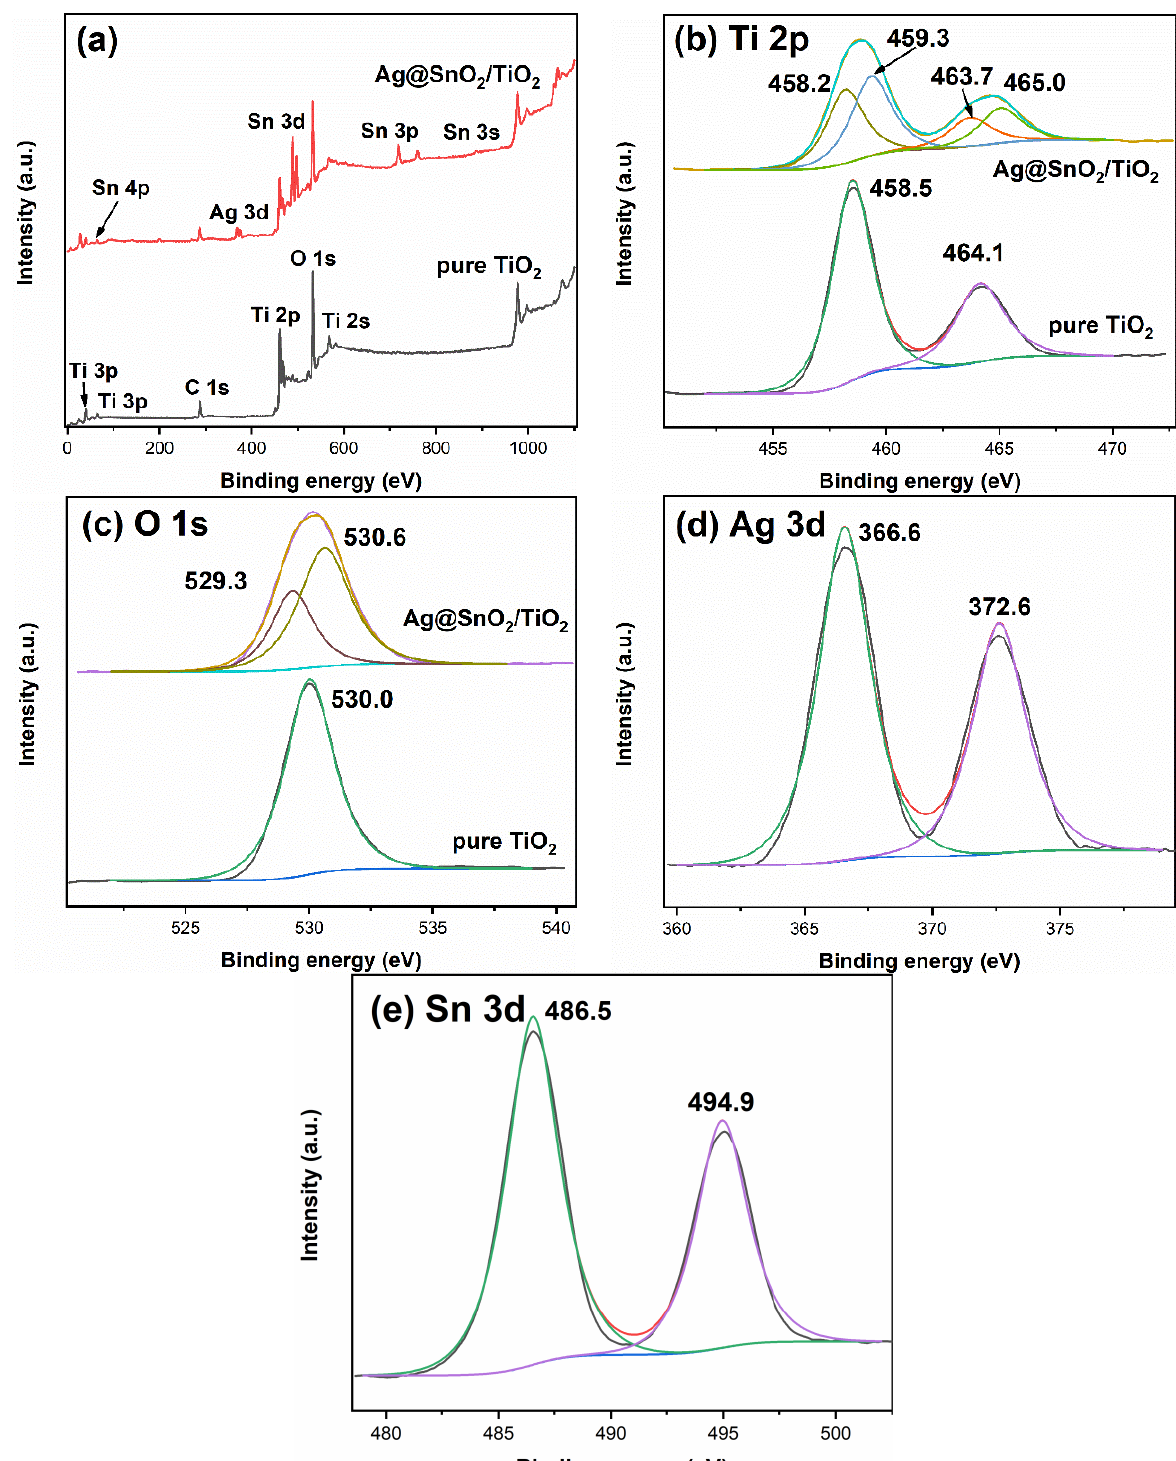
Figure 4. XPS spectra of pure TiO 2 and Ag@SnO 2 /TiO 2 : total spectra ( a ), Ti 2p ( b ), O 1s ( c ), Ag 3d ( d ) and Sn 3d ( e ).